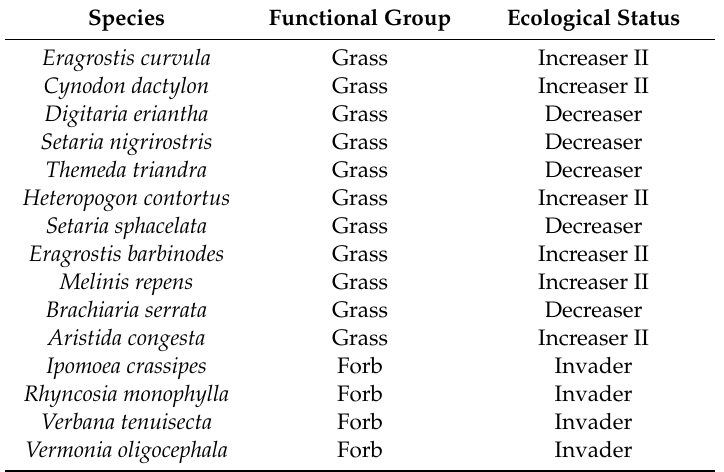
Table 2. Table showing di ff erent plant species occurring at the experimental